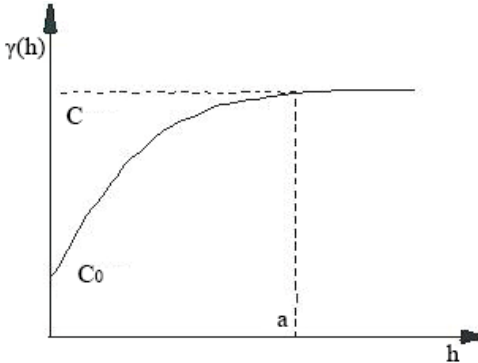
Figure 3. Model variogram.